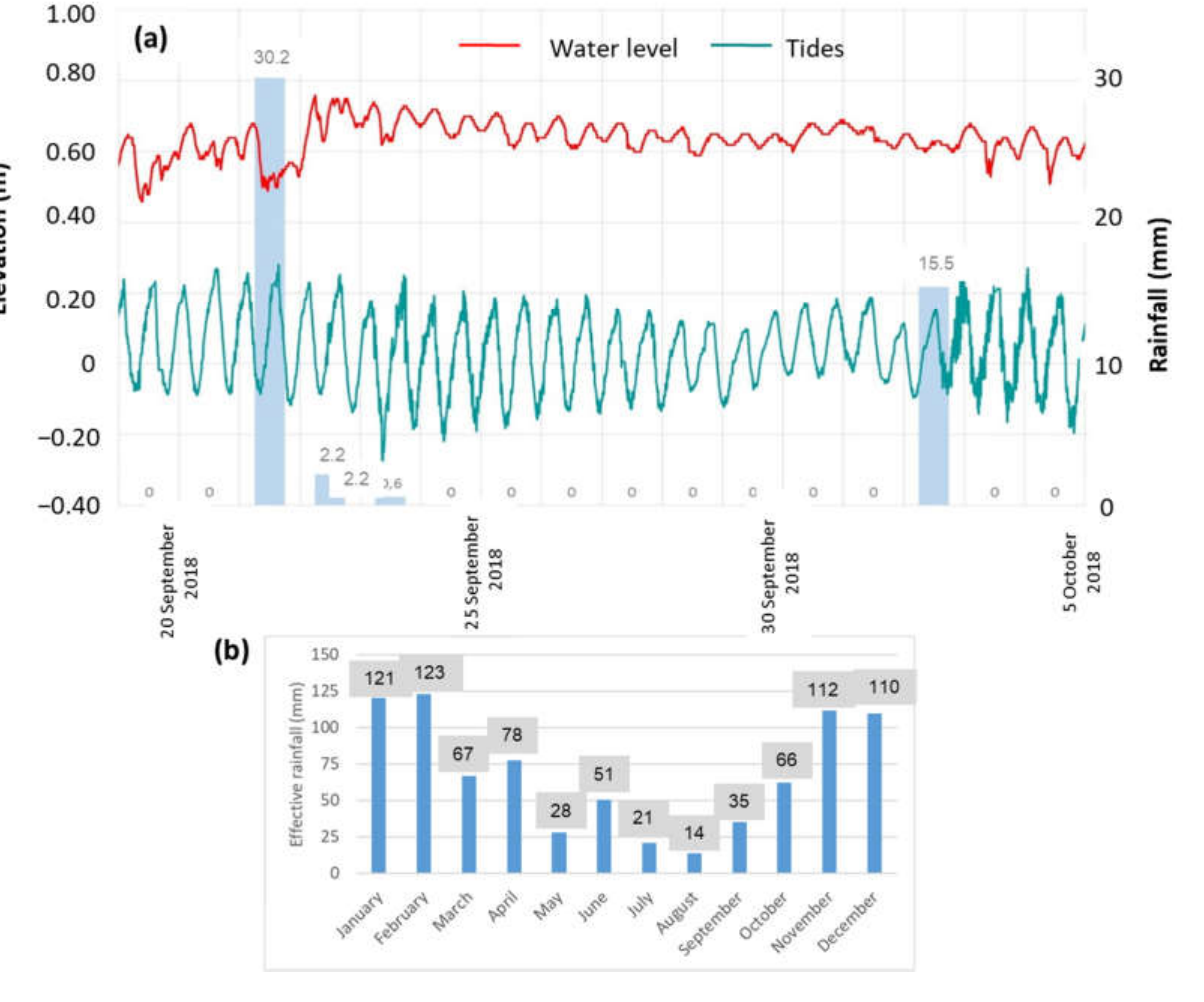
Figure 4. ( a ) Upper: water level fluctuations at well RGI_001 (red), ocean tides (green), and rainfall (blue histogram); ( b ) lower: monthly efficient rainfall computed using soil water budget with S max = 20 mm. Table 2. Characteristics of the wells to which the modified Henry’s relationship has been